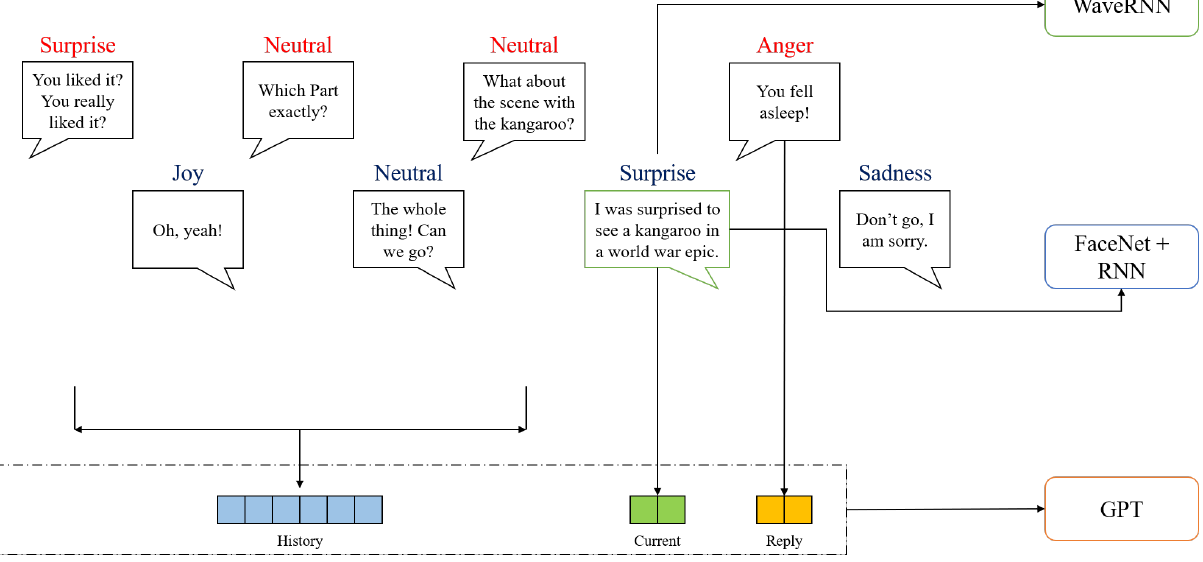
Figure 2. The crossmodality attention fusion